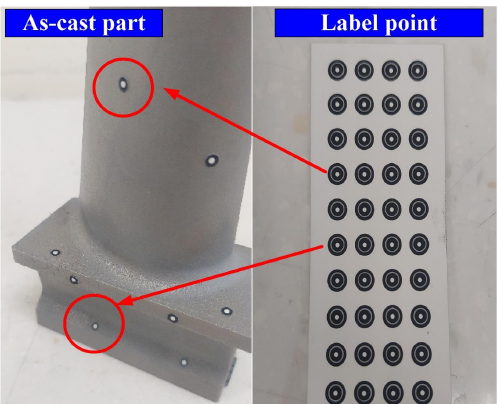
Figure 3. As-cast part after labeling the points.